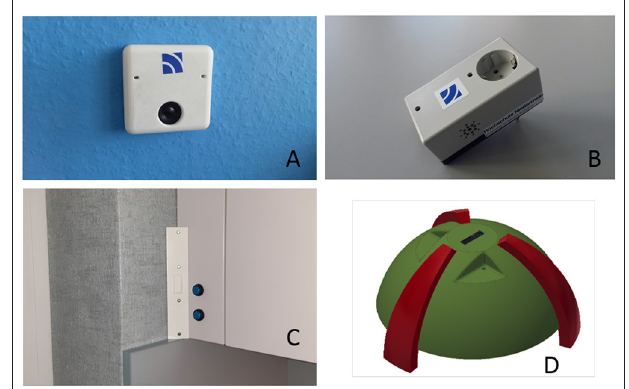
FIGURE 2 | Implementation of client devices in an outlet socket (A) , as a switchable power socket (B) , in a furniture corner (C) , and as a stand-alone device (D)